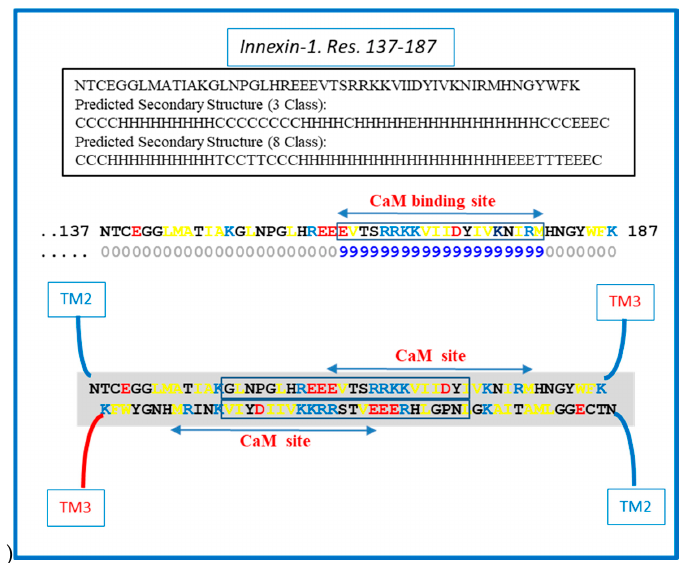
Figure 6. Hypothetical CL–CL interaction between Cx43 sequences. If present, the interaction might involve several hydrophobic residues and include the CL2 ′ s calmodulin (CaM) binding site. Based on the prediction of the secondary structure (see above), the potential CL–CL interacting sequence (R148–K162) is believed to be in alpha-helical conformation. The secondary structure prediction was performed by SCRATCH Protein Predictor, School of Informatics and Computer Sciences (ICS), University of California, Irvine (UCI).